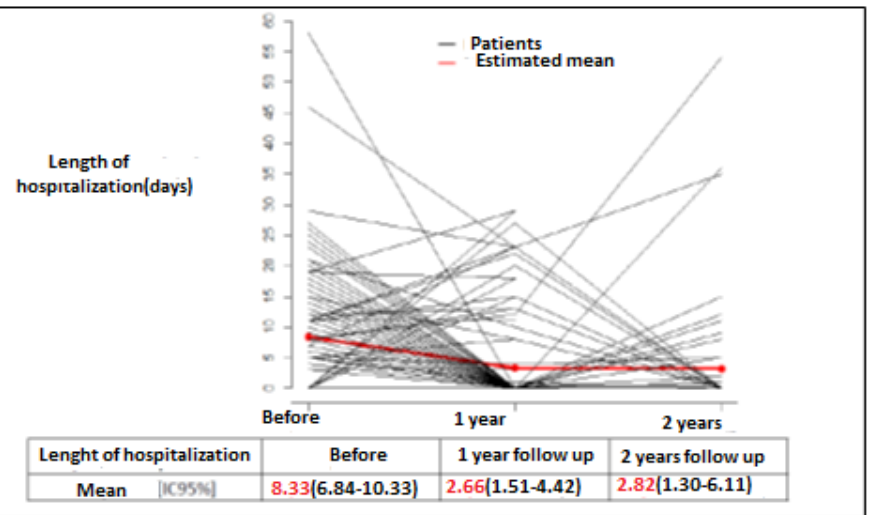
Figure 2. Number of days hospitalized per patient per year before and after inclusion in the USICAR ( Unité de Suivi des Patients Insuffisants Cardiaques ) program. This figure shows the results of the primary endpoint analysis, i.e., the number of days hospitalized for heart failure per patient per follow-up period. The red curve corresponds to the mean number of days hospitalized for heart failure for all patients and for each follow-up period; the curve decreases in the first year, and then remains stable after two years of follow-up. Table 3. Comparison of the ratios of means for the number of days hospitalized for heart failure per patient per year before and after inclusion in the USICAR ( Unité de Suivi des Patients Insuffisants Cardiaques ) program.